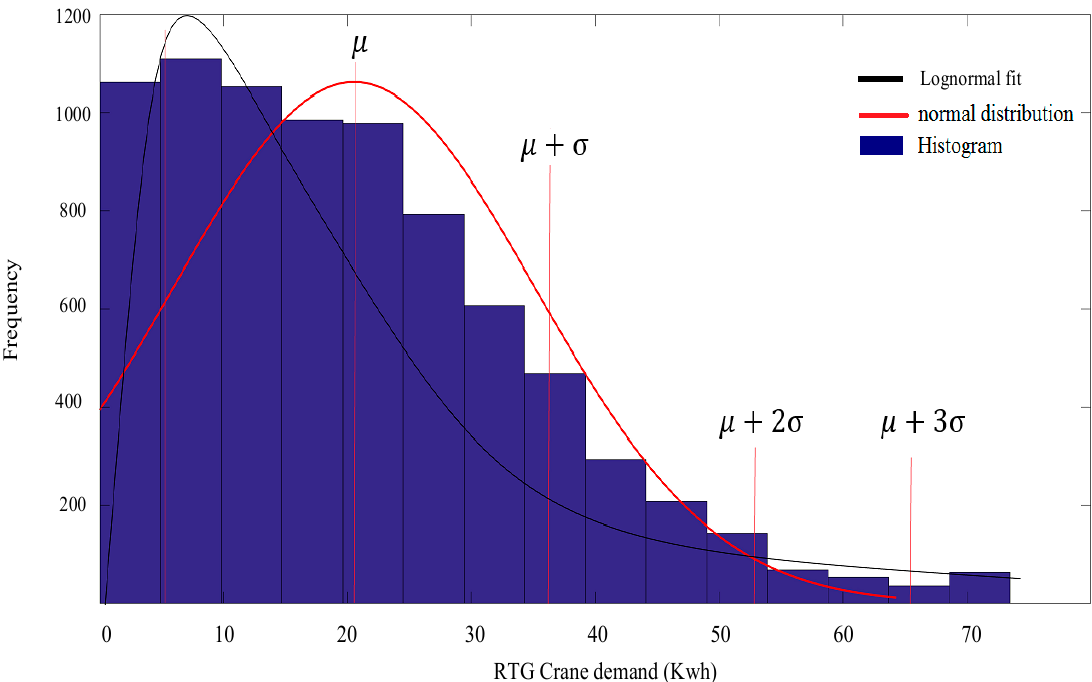
Figure 3. Illustration of RTG crane demand data in a histogram along with a normal distribution fit and lognormal.